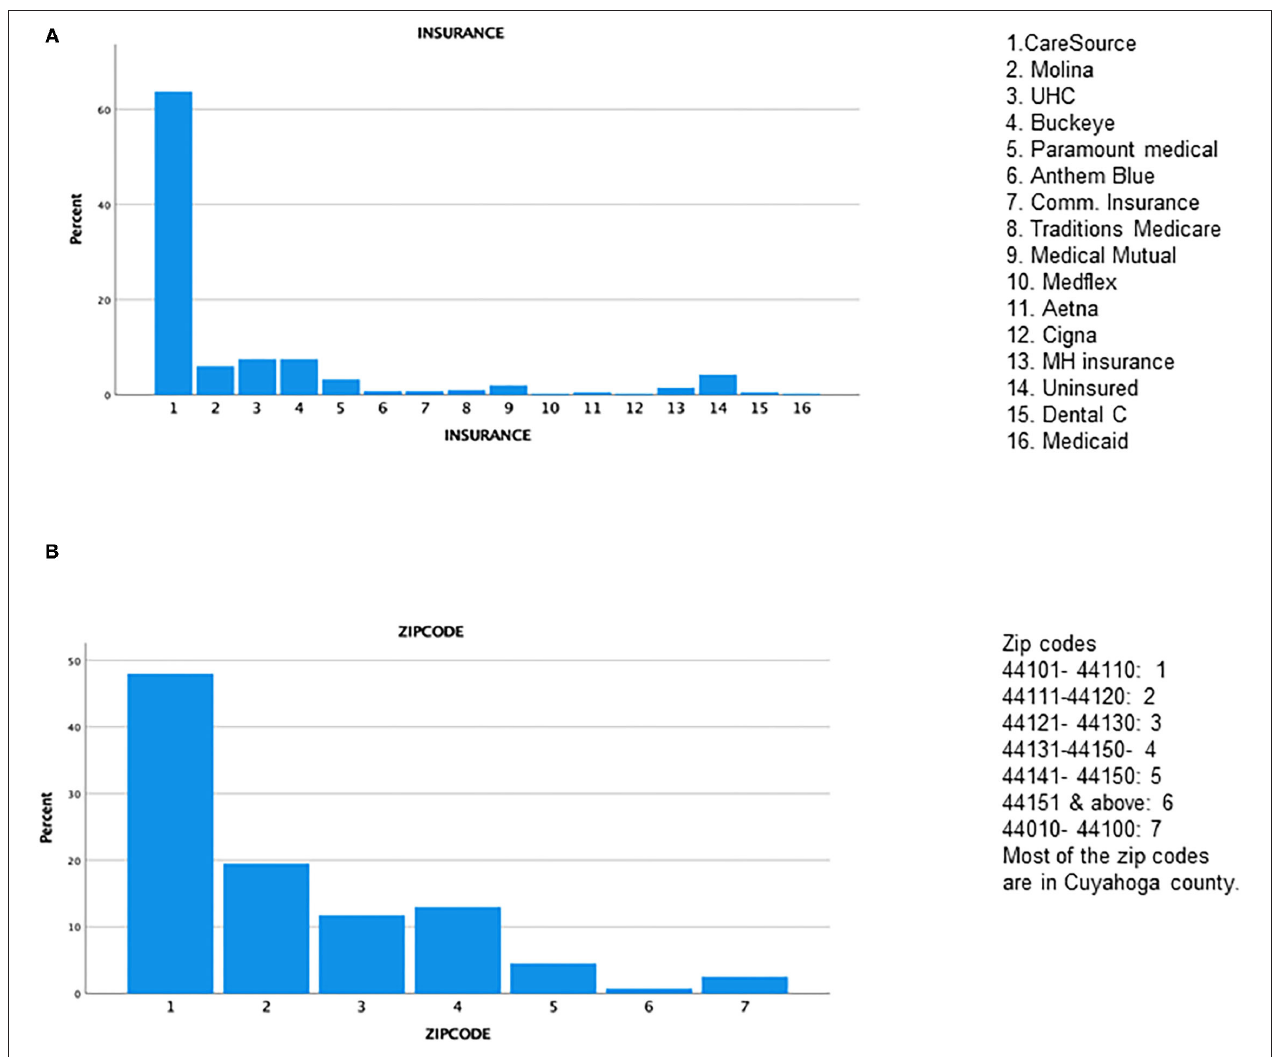
FIGURE 2 | (A) Insurance status. (B)